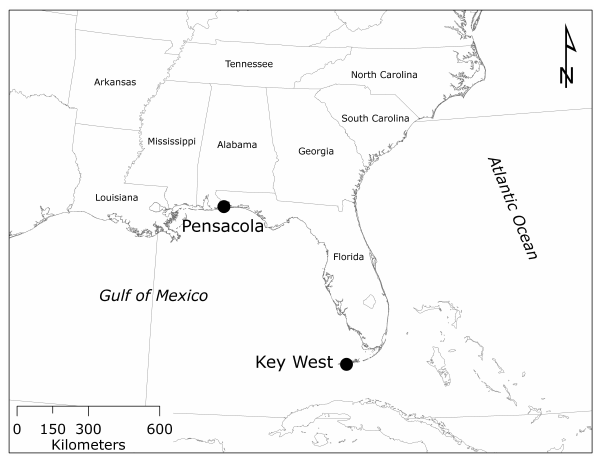
Fig. 1. Location of Pensacola and Key West,